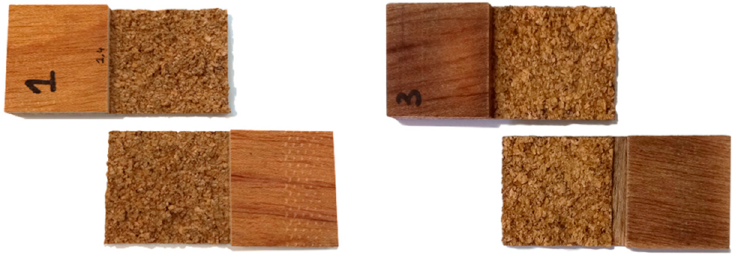
Figure 3. Total (100%) cohesive failure of the cork core (0% wood failure) on specimens tested after dry conditioning ( left ) and immersion in boiling water ( right ). The numbers 1 and 3 on the specimens are testing codes referring to the panels from which they were cut.